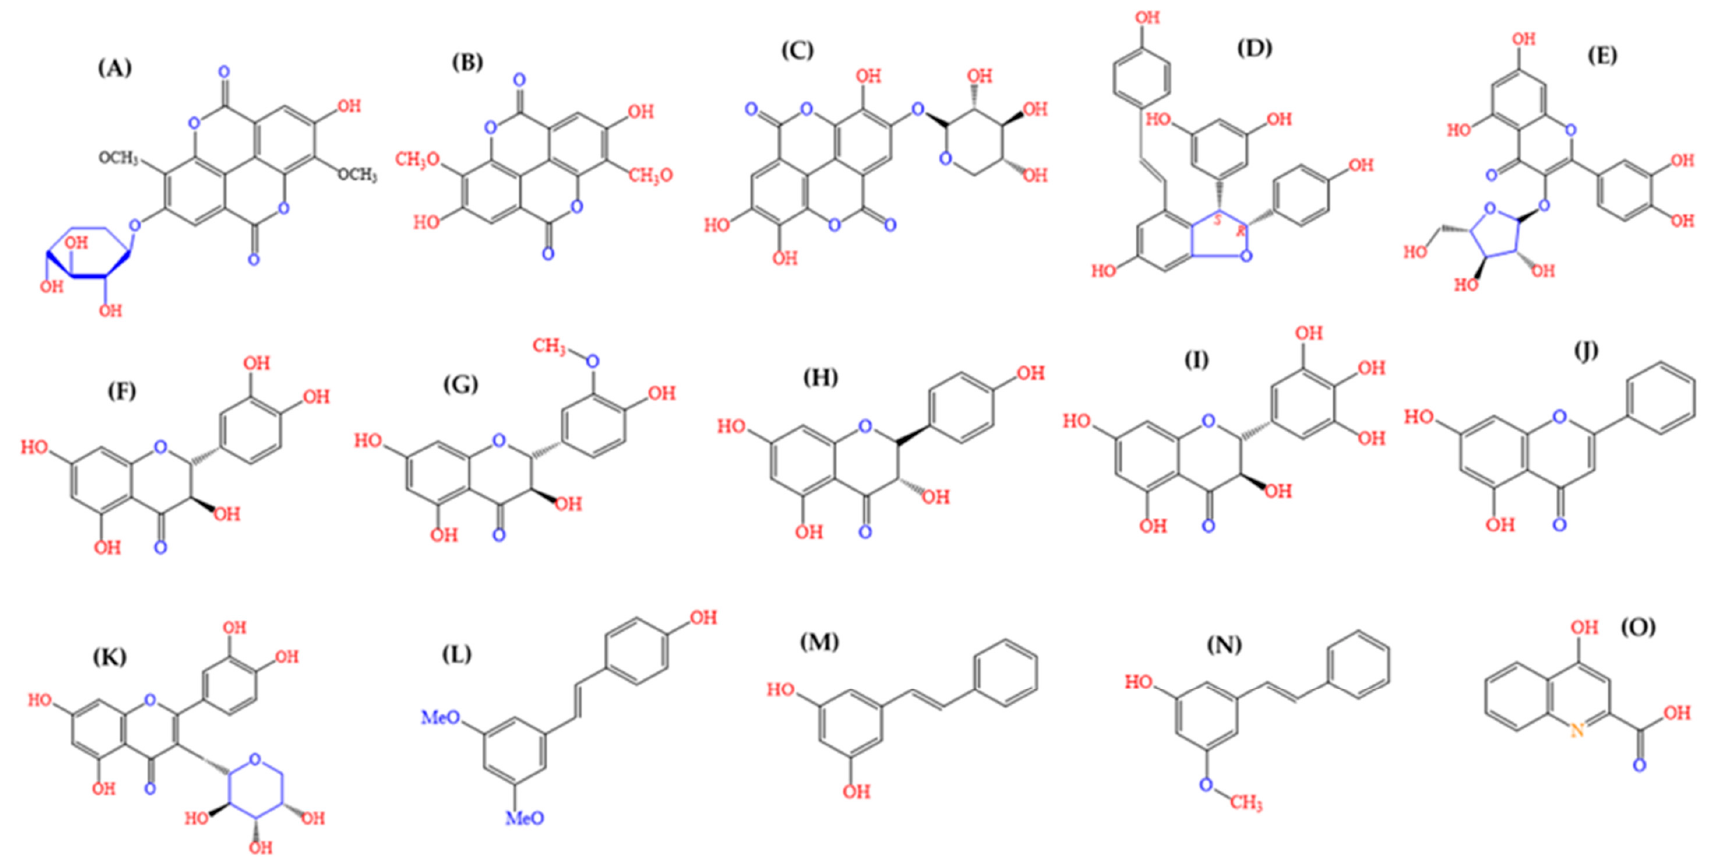
Figure 3. Chemical structure of ellagic acid derivatives and other chemical constituents detected earlier from A. leiocarpa : ( A ) dimethyl ellagic acid xylopyranoside, ( B ) dimethyl ellagic acid, ( C ) ellagic acid xylopyranoside, ( D ) epsilon-Viniferin, ( E ) avicularin, ( F ) taxifolin (dihydroquercetin), ( G ) methyl-taxifolin (dihydroisorhamnetin), ( H ) aromadendrin (dihydrokaempferol), ( I ) ampelopsin (dihydromyricetin), ( J ) pinocembrin, ( K ) guaijaverin, ( L ) pterostilbene, ( M ) pinosylvin (trans-dihydroxystilbene), ( N ) methyl pinosylvin, and ( O ) kynurenic acid [18,26,27]. Source for molecular structures: (CAS), 2020.